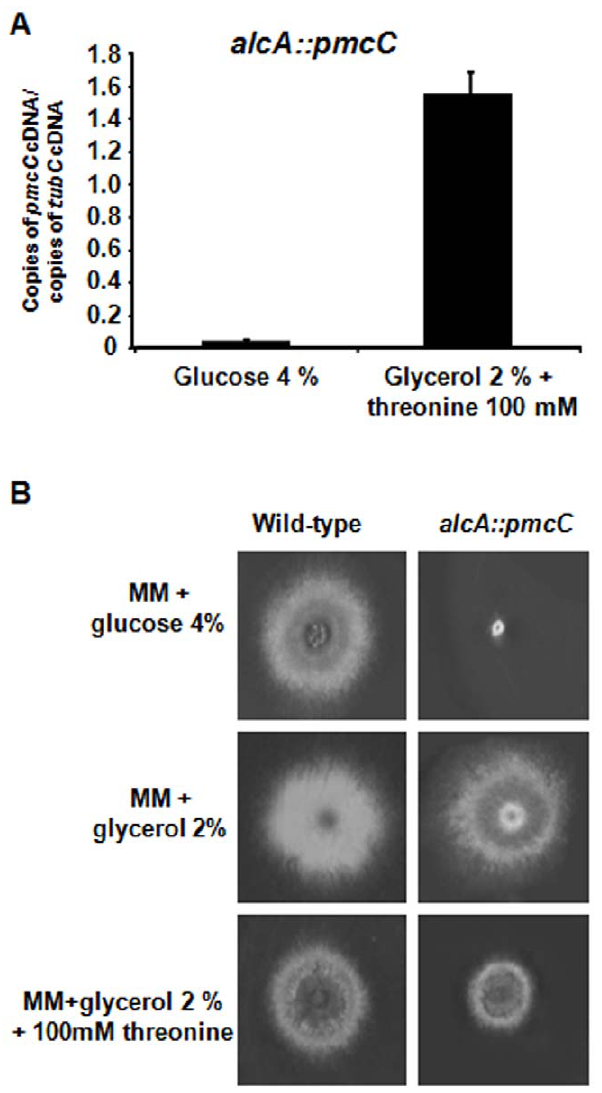
Figure 3. The pmcC gene is an essential A.fumigatus gene. (A) The alcA::pmcC strain was grown for 16 hours in MM + 2% glycerol at 37 u C and transferred into either MM + 4% glucose or MM + 2% glycerol + threonine 100 mM and grown for further 6 hours. The relative quantitation of pmcC and tubulin gene expression was determined by a standard curve (i.e., C T –values plotted against a logarithm of the DNA copy number). The results are the means ( 6 standard deviation) of four biological replicates. (B) Growth phenotypes of the alcA::pmcC mutant strain. The A. fumigatus wild-type and alcA::pmcC mutant strains were grown for 72 hours at 37 u C in MM + 4% glucose, MM + 2% glycerol and MM + 2% glycerol + threonine 100 mM.